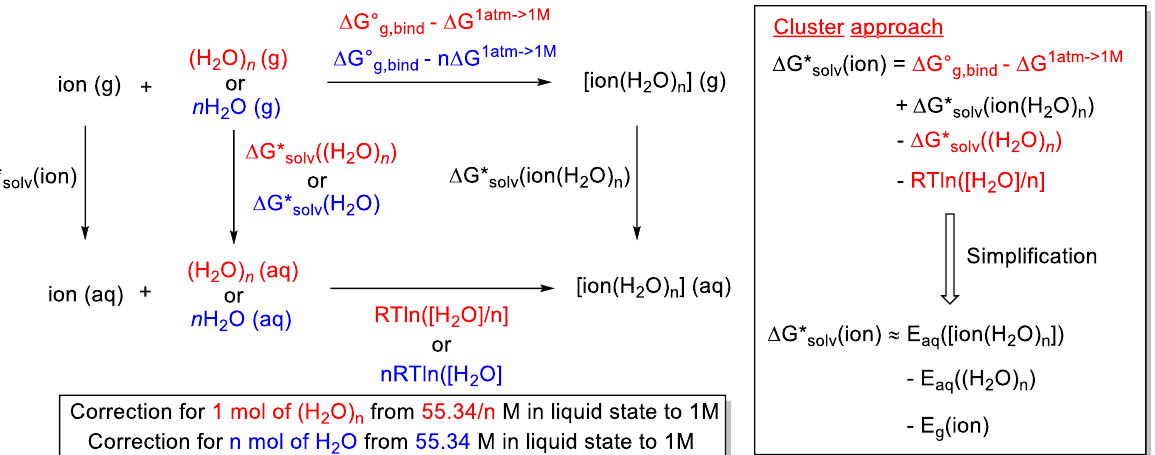
Figure 16. Thermodynamic cycle. * = standard state of 1M, and ° = standard state of 1atm. Red: cluster model. Blue: monomer model. Δ G 1atm->1M = RT ln(24.46) is the correction from 1atm of an ideal gas to 1M, where R = 0.08206L atm K −1 mol −1 is the universal gas constant, and T is the temperature in Kelvin. E aq is the electronic energy of the species calculated with implicit solvation, and E g is the electronic energy in the gas phase. For assumptions involved in simplification, please refer to Wu and Kieffer [157].